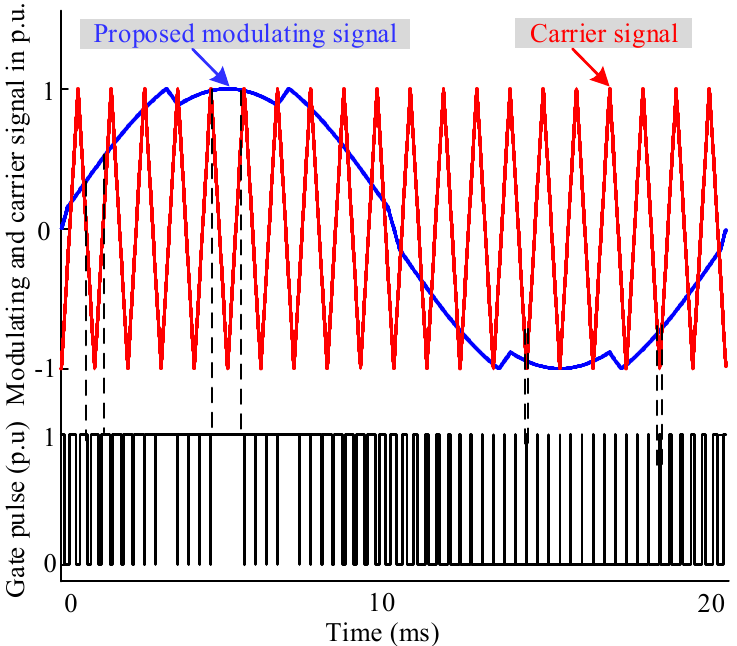
Figure 7. Illustration of gate pulse generation scheme using proposed TSCMPWM technique for 5-level MMC inverter (only modulating signal, Sa is shown here to demonstrate the system for better view). This proposed switching technique is applied to the 3-phase 5-level MMC inverter for PV system, where the values taken for A and C are 1.09 and 0.84, respectively, at modulation index 1. Figure 8 shows the inverter output line voltage and its frequency spectra. The THD of the inverter output line voltage for the proposed technique is 13%, which is lower than the existing six modulation techniques.